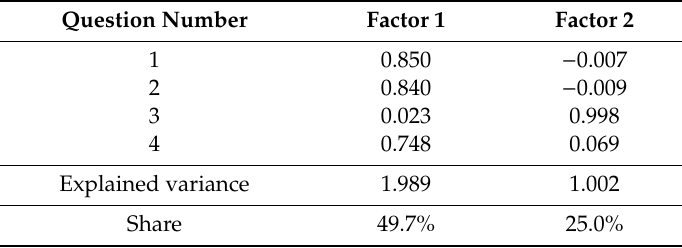
Table 3. Factor loadings after varimax